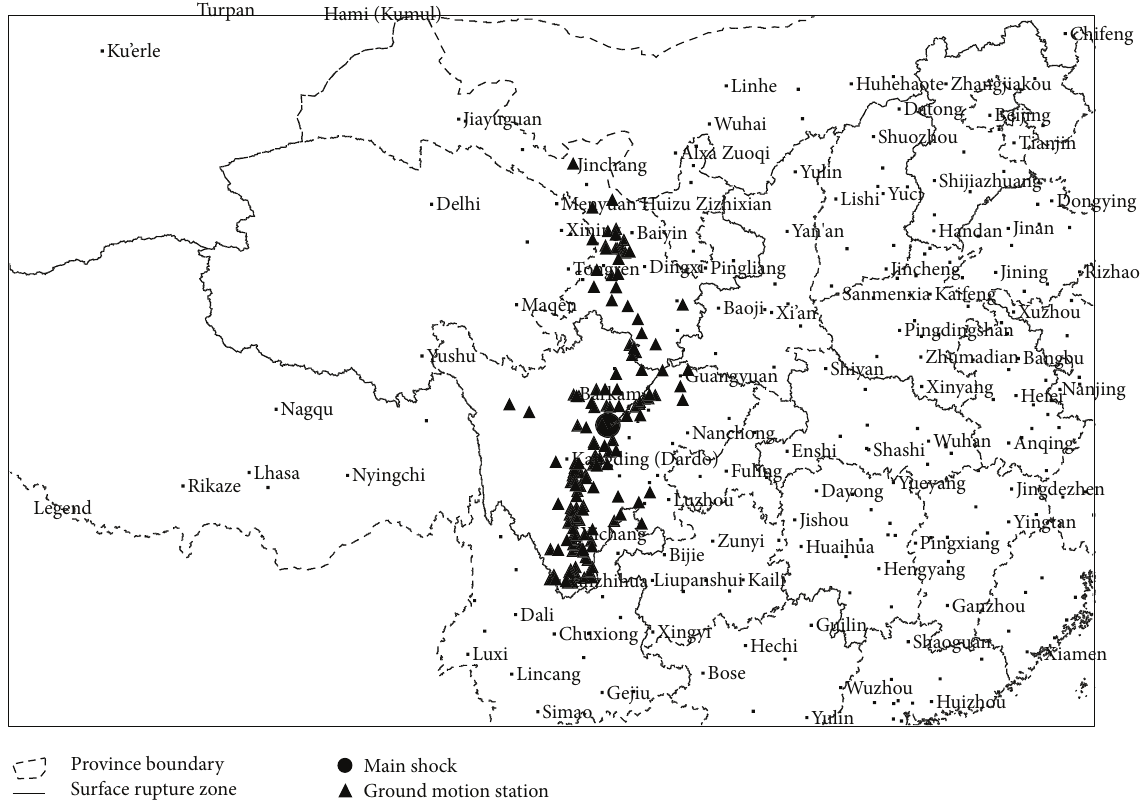
Figure 1: Station distribution around the main shock.